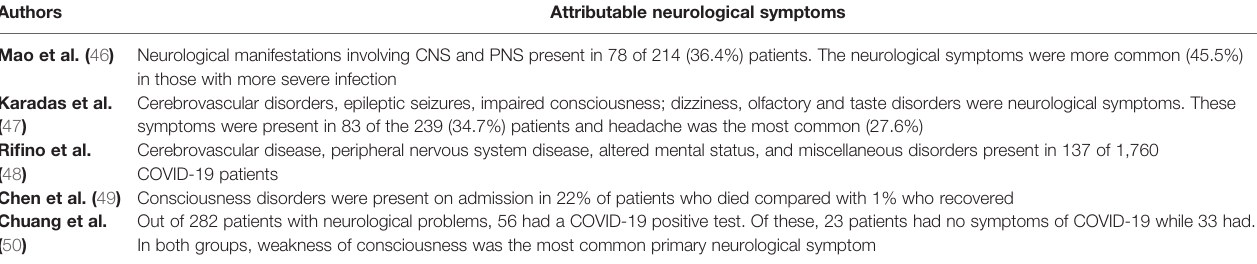
TABLE 1 | Neurological symptoms attributable to SARS-CoV-2 published in 2020 and 2021. Authors Attributable neurological